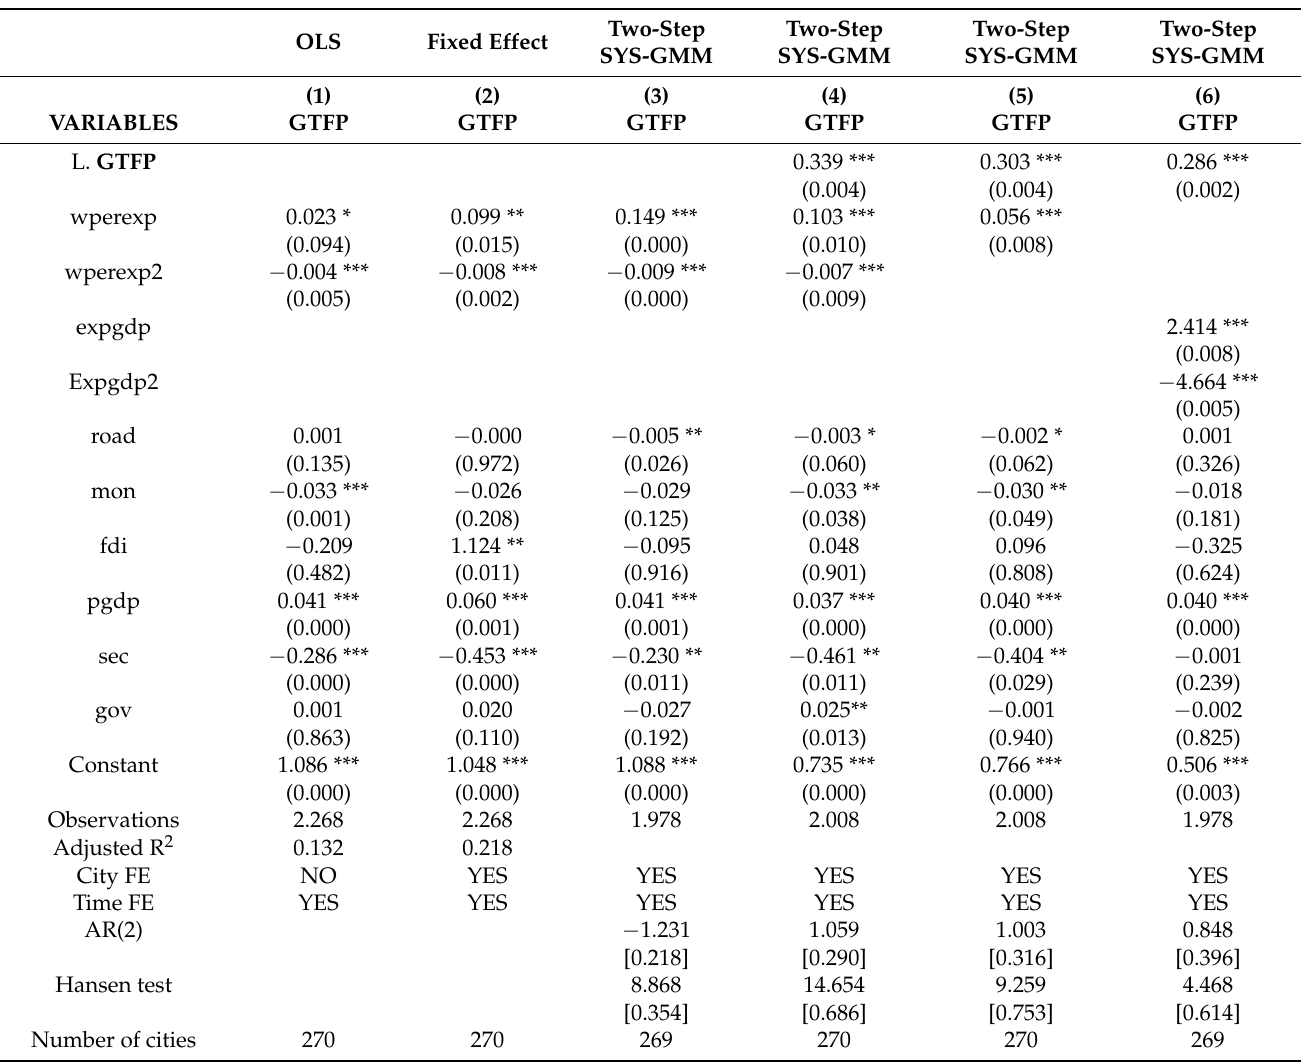
Table 6. Estimation results of public expenditure scale on